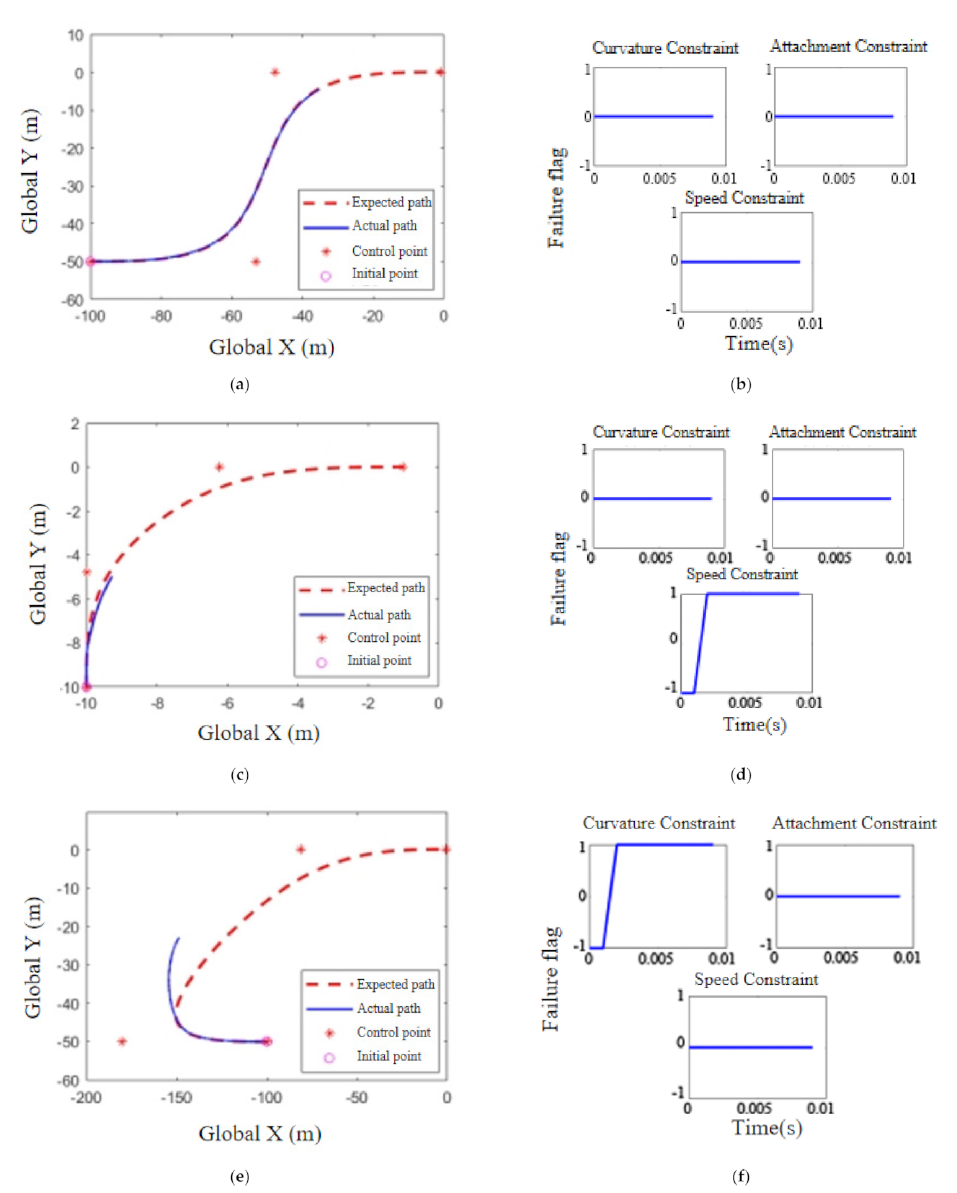
Figure 6. Simulation test of path planning failure monitoring strategy: ( a ) Vehicle path; ( b ) Failure flag; ( c ) Vehicle path; ( d ) Failure flag; ( e ) Vehicle path; and ( f ) Failure